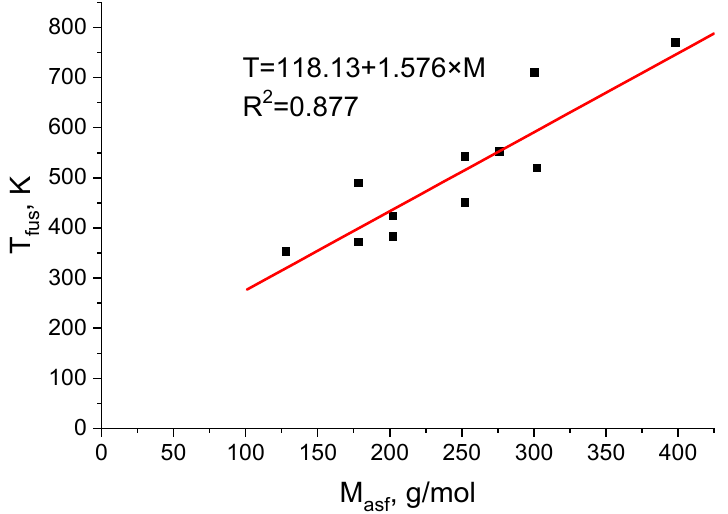
Figure 1. Correlation dependence of the melting point of polyaromatic compounds on their molecular weight.